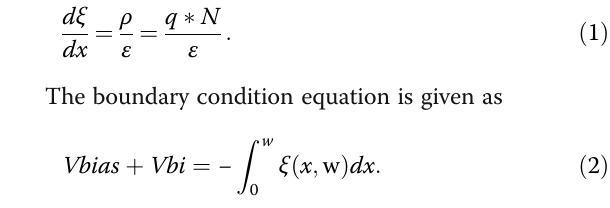
APD epitaxial structure for the simulation is shown in Fig. 1. From bottom to top, the layers are sequentially named as substrate, contact layer, cladding layer, multi- plication layer, charge layer, grading layer, absorption layer, grading layer, cladding layer, and contact layer.